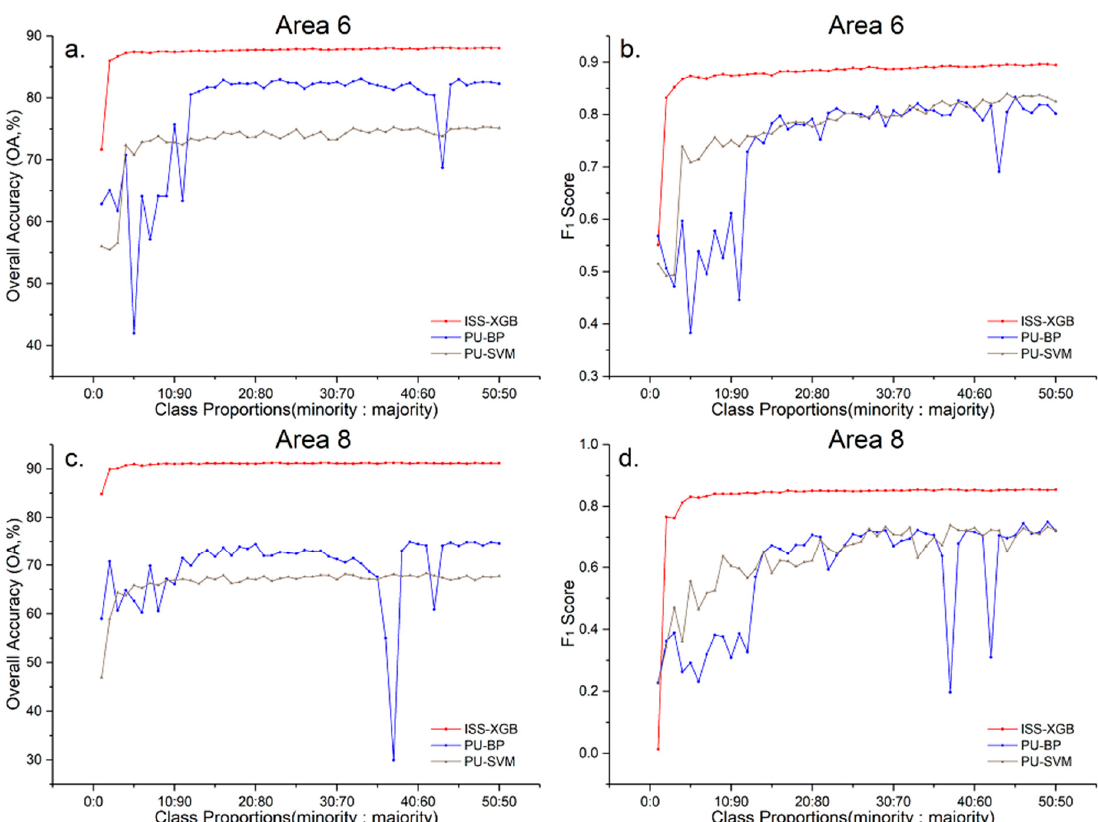
Figure 9. OA and F 1 score curves for the minority classes in Areas 6 and 8 across different imbalanced samples with ISS-XGB (red), PU-BP (blue), and PU-SVM (grey). Sub-figure ( a , b ) are the accuracy curves for Area 6 (( a ): OA; ( b ): F 1 score). Sub-figure ( c , d ) are the accuracy curves for Area 8 (( c ): OA; ( d ): F 1 score).